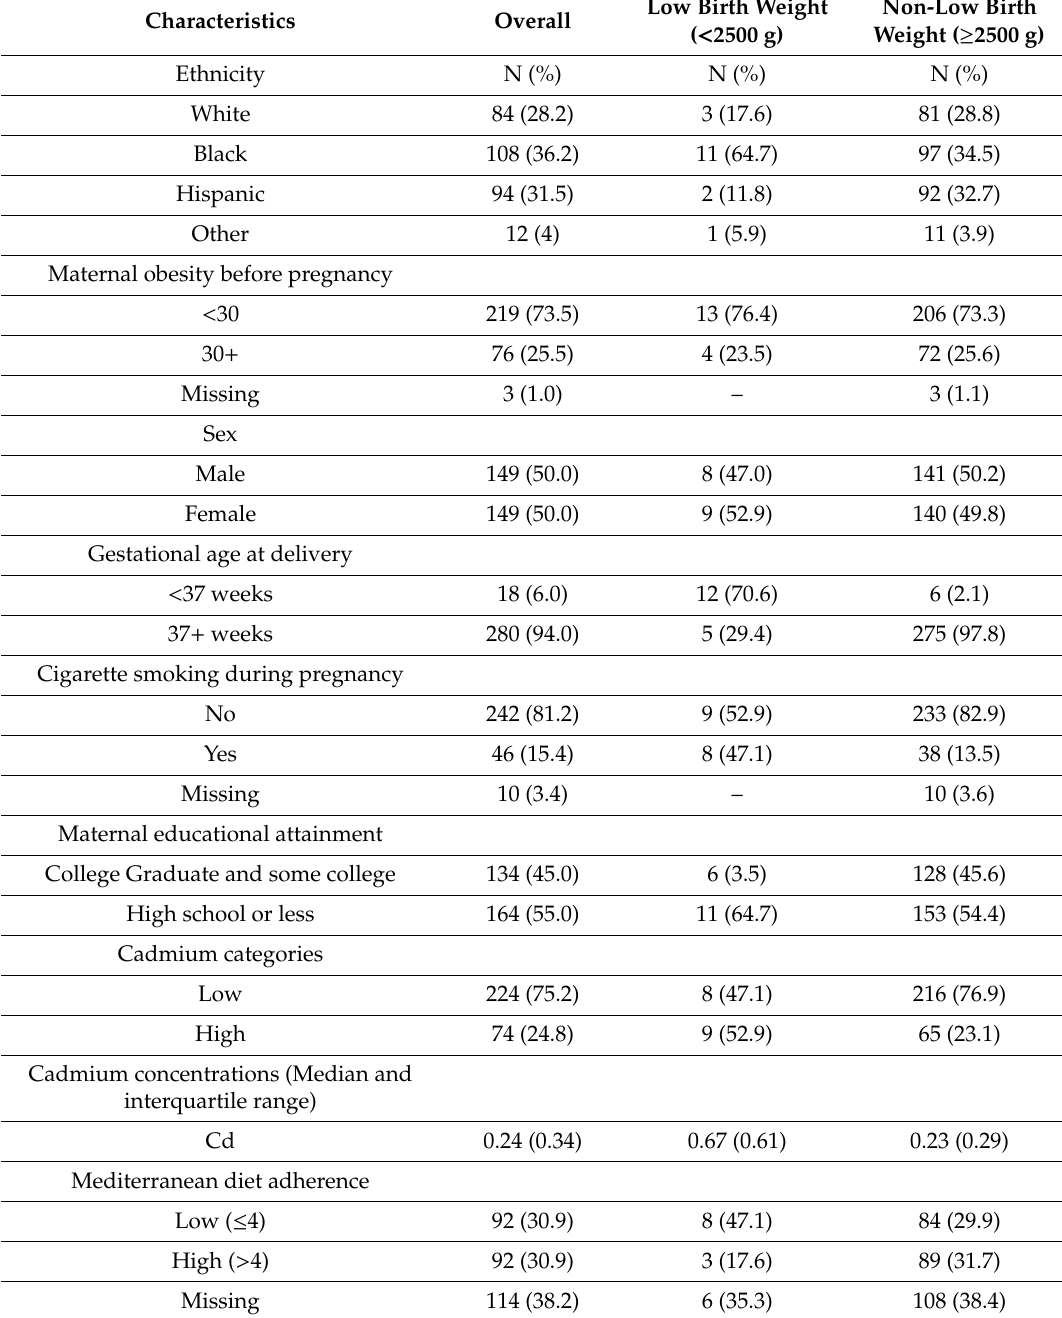
Table 1. Sociodemographic characteristics of study participants by birth